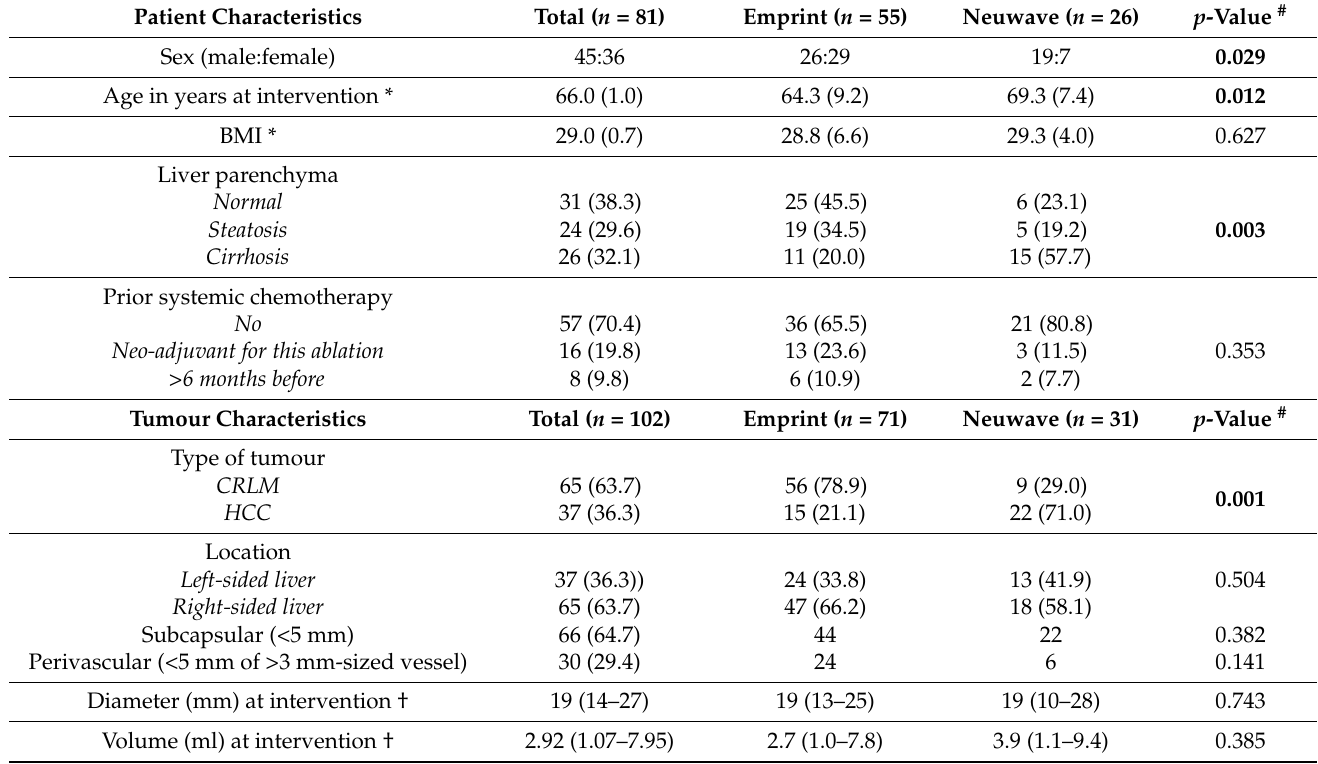
Table 1. Clinicopathological